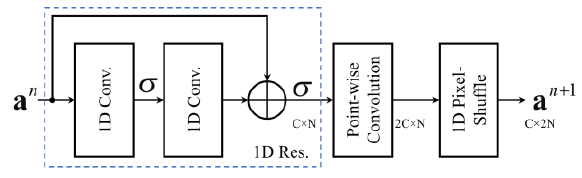
Figure 8. Layer structure of decoders 1 – 7.